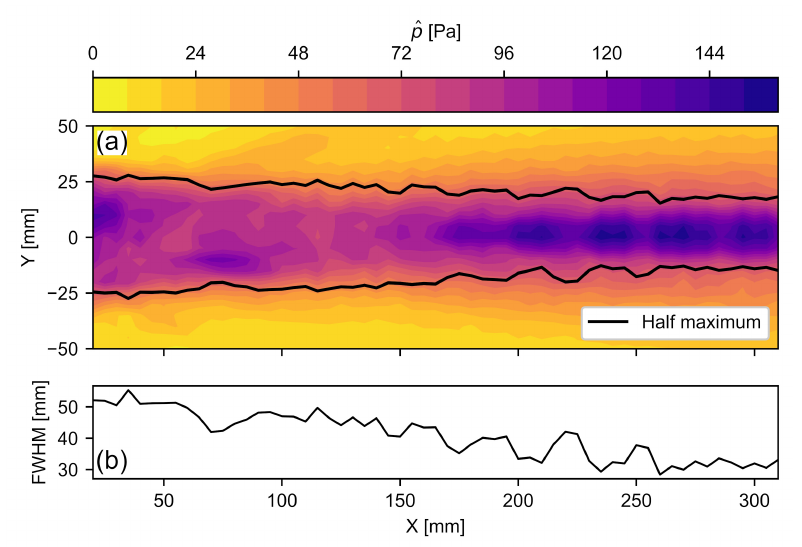
Figure 5. ( a ) Sound field of the Ultran NCG100-S63 transducer in the center plane, where ˆ p is the maximum sound pressure. The pressure data originate from a previous study [56]. ( b ) The full width at half maximum (FWHM) along the